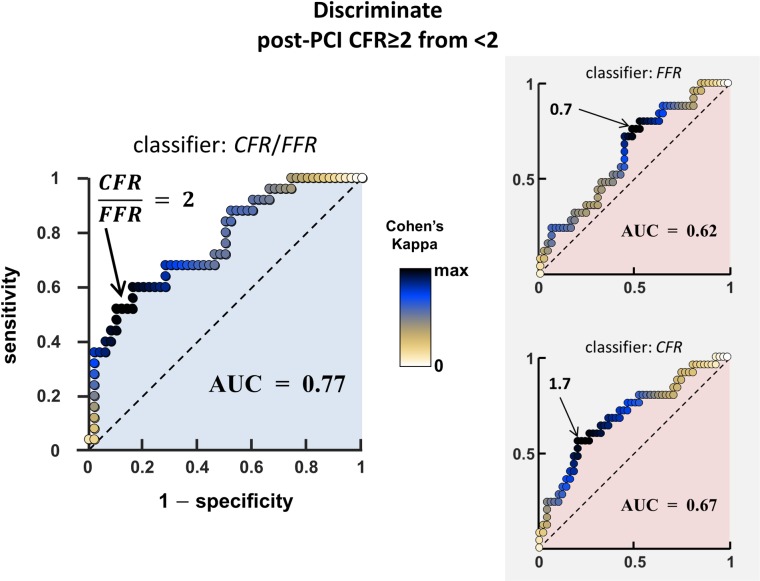
ROC analysis.Accuracy of the CFR-to-FFR ratio to discriminate post-PCI CFR>2 from post-PCI CFR<2. AUC = area under the ROC curve. The colored disks represent the Cohen’s kappa statistic. The ROC curves of the FFR and CFR classifiers are also represented for comparison.